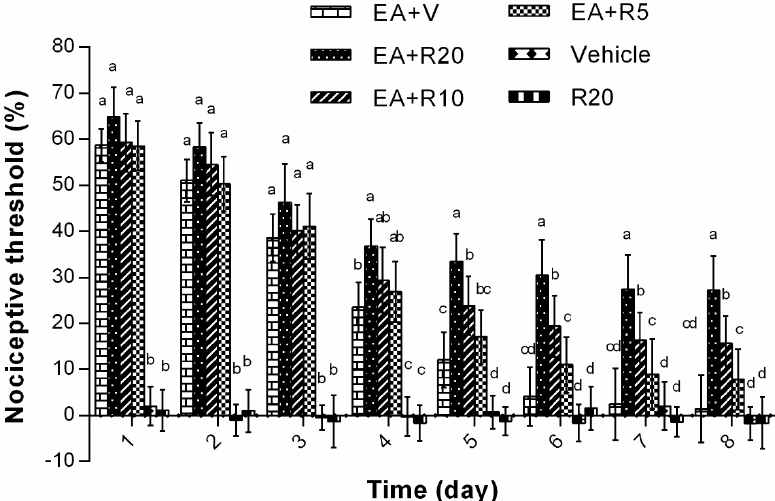
Figure 5. The effect of intrathecal administration of riluzole on changes of tail flick latency in EA-treated rats (Mean ± SD, %, n = 6). EA was given once per day for eight consecutive days. Riluzole or vehicle was given once daily 30 min prior to EA. The significance of differences was calculated by a one-way ANOVA. EA + V: EA plus vehicle; EA + R20: EA plus 20 μ g riluzole; EA + R10: EA plus 10 μ g riluzole; EA + R5: EA plus 5 μ g riluzole; R20, 20 μ g riluzole. The values with different letters (a–d) at the same day differ ( p < 0.05).